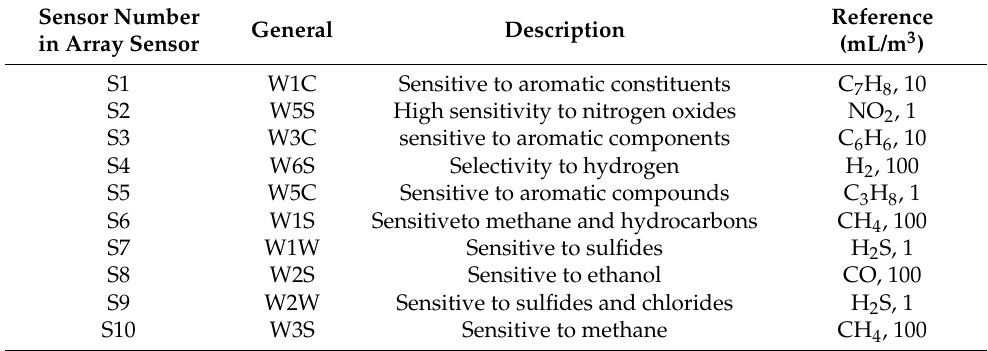
Table 3. Sensor properties of PEN3 electronic